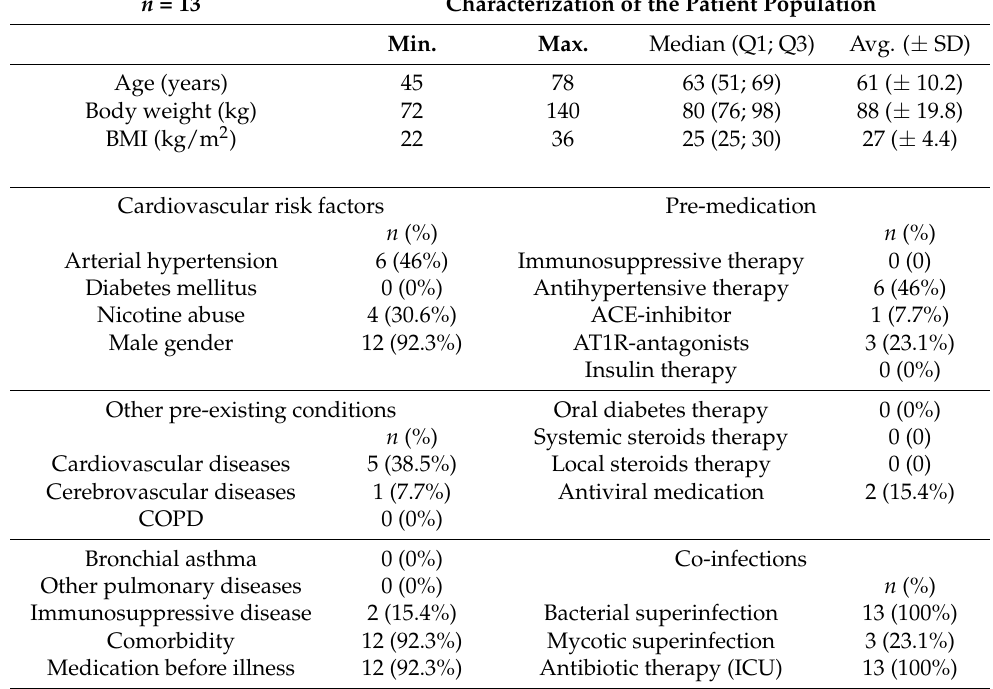
Table 1. Characterization of the severe acute respiratory syndrome coronavirus 2 (SARS-CoV-2) acute respiratory distress syndrome (ARDS) patient population, including cardiovascular risk factors and other pre-existing conditions, pre-medication, and